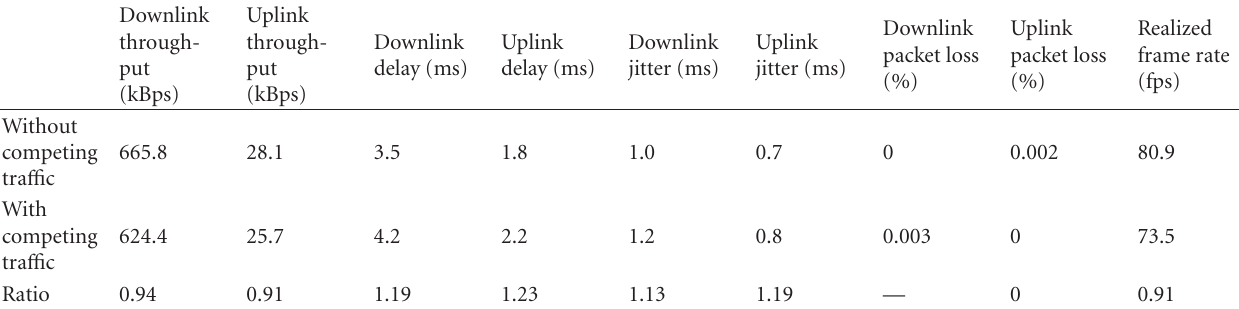
Table 4: Average values when the game has higher priority than the background tra ffi